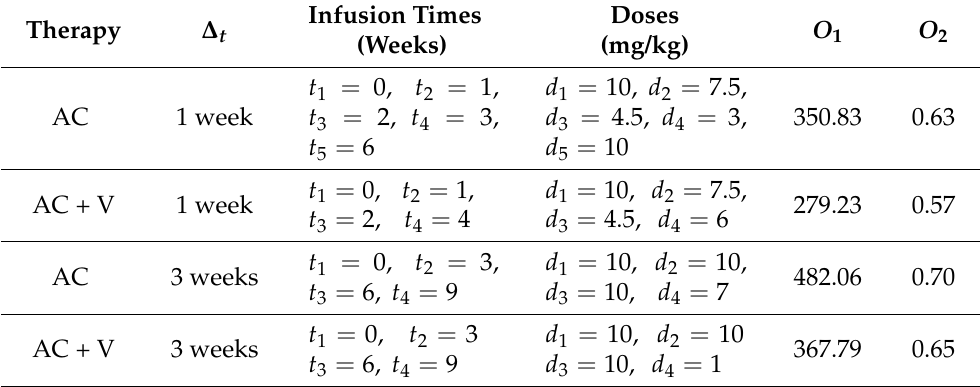
Table 5. Numerical results for the optimization problem OP2. Anti-CTLA4 has been administered as mono-therapy (AC) and in combination with dendritic cell vaccine (AC + V). Both the immunothera- pies have been tested by taking into account the general constraints defined in Section 2.5 and an additional constraint concerning the minimum time interval between two infusions ( ∆ t ) fixed as 1 or 3 weeks. Column three and four list the infusion times and doses predicted by the model as the optimal schedules. The values O 1 and O 2 represent the first two components of the optimization function, namely O 1 =